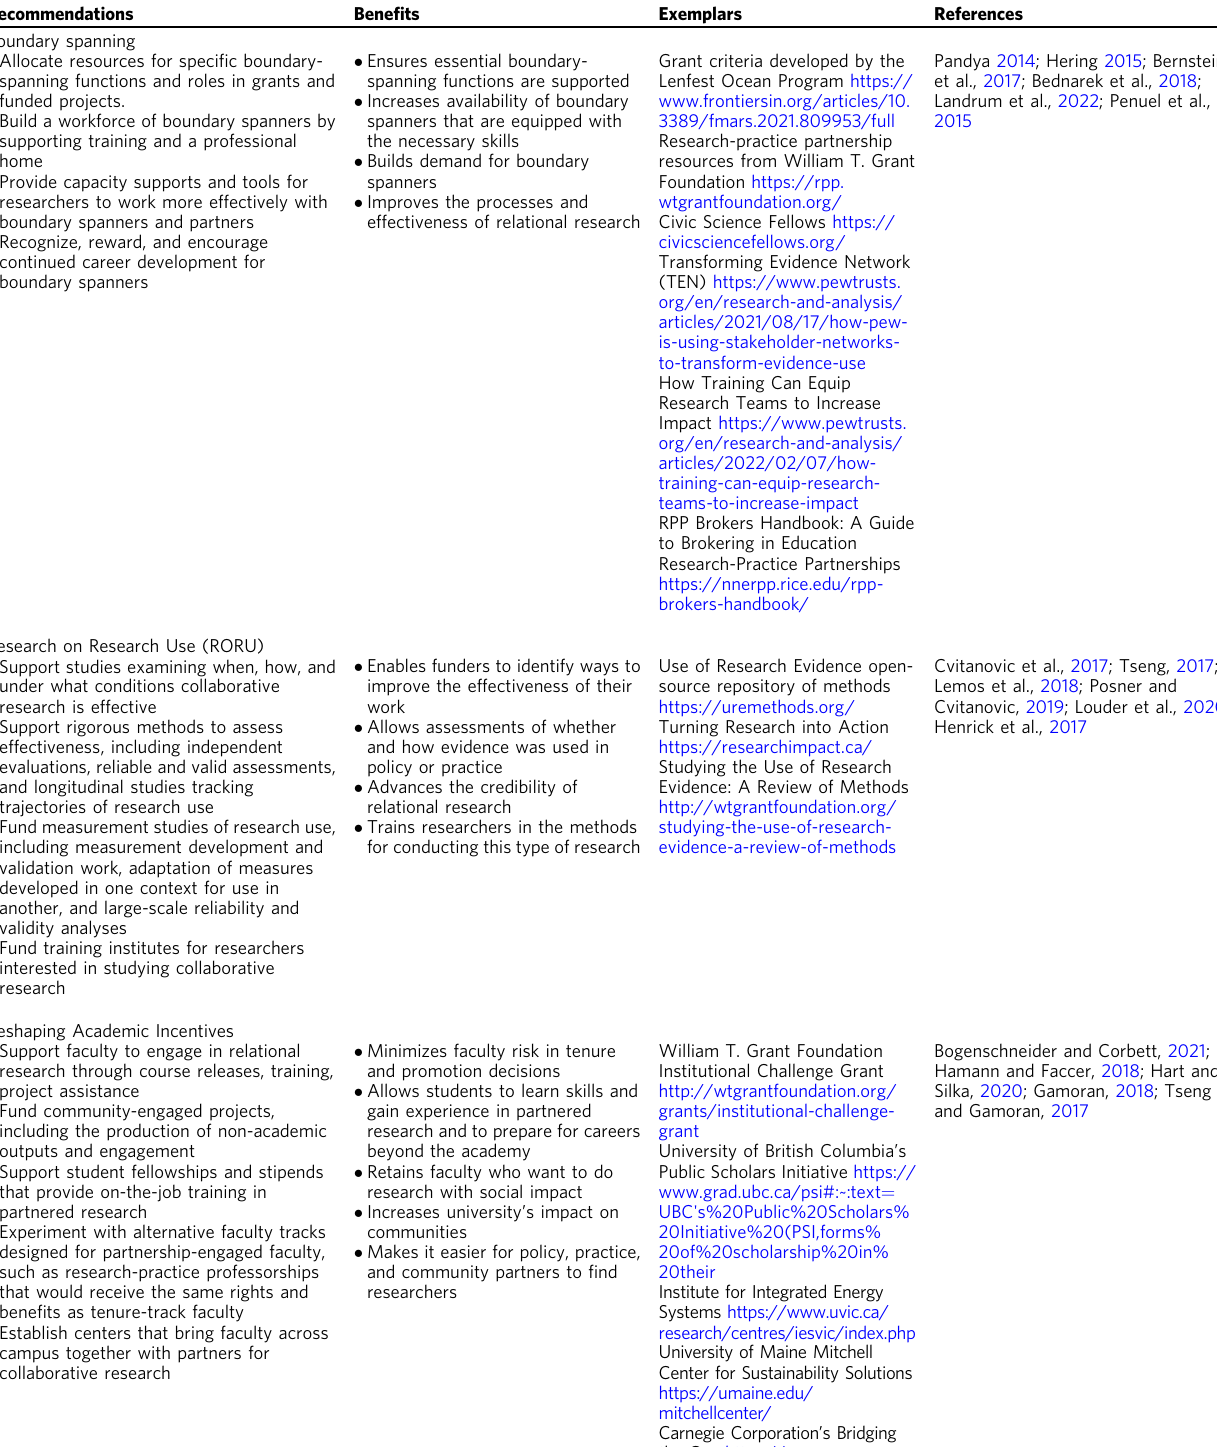
Table 1 Recommendations for